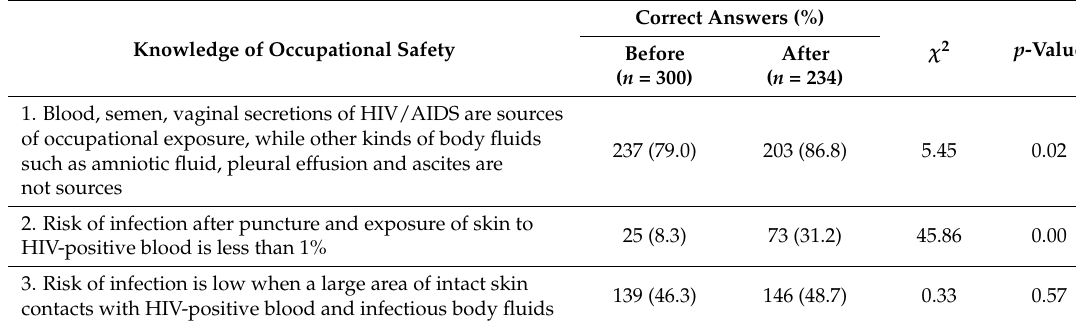
Table 5. Intervention and risk perception